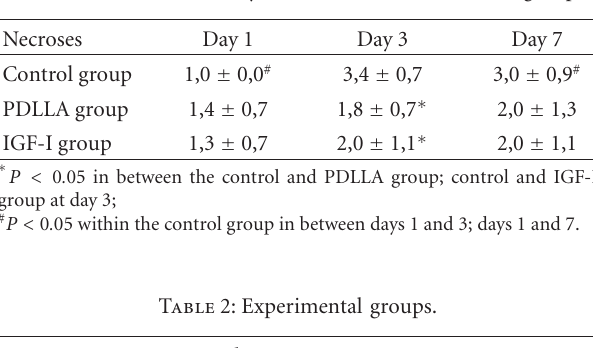
Table 1: Analyses of the necrotic tissue reaction at the anastomoses in between the groups at day 1, 3, and 7 after surgery. Significant less necroses were seen at day 3 and 7 in the IGH-I-treated group.